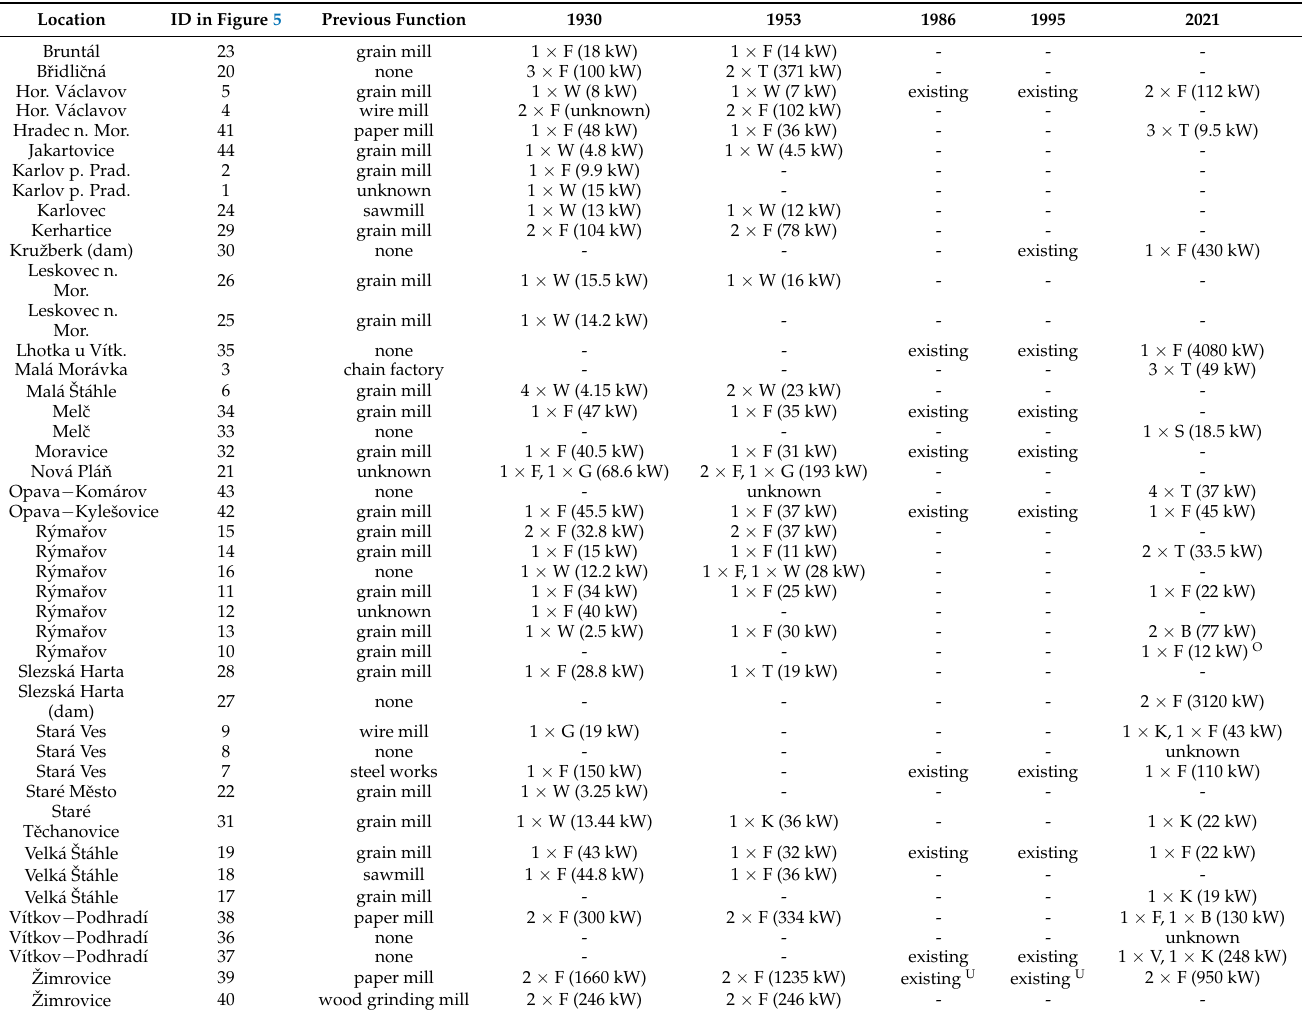
Table 4. A list of the hydropower plants in the Moravice river basin between 1930 and 2021, including the types of water engines * and power, where available (sorted